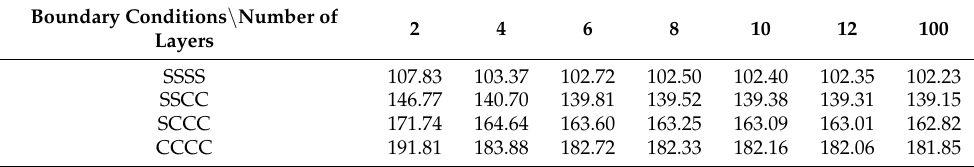
Table 3. The free frequencies ω (rad/s) of GPL reinforced porous composite plates—effect of total layer number and the boundary